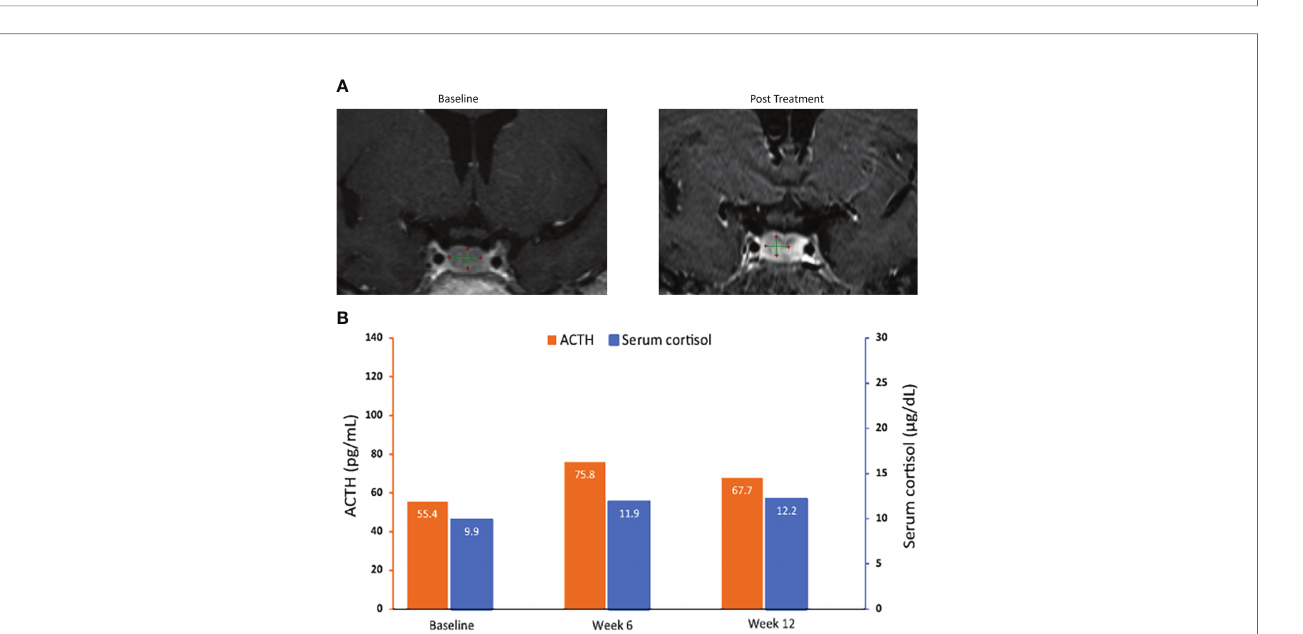
FIGURE 5 | MRI of pituitary macroadenomas (A) and ACTH and cortisol levels (B) in case 3: a 50-year-old woman with Cushing disease treated with relacorilant for 12 weeks. (A) Coronal post contrast T1-weighted MRI obtained at diagnosis (left image) after administration of gadolinium showed a nodular lesion with reduced enhancement in the median and paramedian anterior part of the sellar region compatible with pituitary macroadenoma. It measured 10.01 × 6.29 × 4.91 mm. Pituitary MRI obtained (right image) within 12 weeks after the last dose of relacorilant showed a reduction in the size of the macroadenoma (8.04 × 5.70 × 3.65 mm). (B) ACTH and cortisol levels. Normal laboratory ranges: ACTH, 6.0-50 pg/mL; serum cortisol, 4.6-20.6 µg/dL. To convert ACTH values from pg/mL to pmol/L, multiply by 0.22. To convert serum cortisol from µg/dL to nmol/L, multiply by 27.6. ACTH, adrenocorticotropic